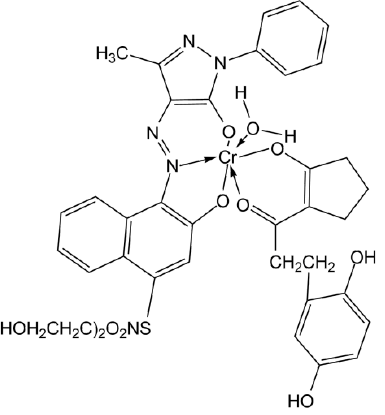
Figure 4. Structure of the magenta dye developer present in Polacolor 2 films and identified in the studied mock-up.